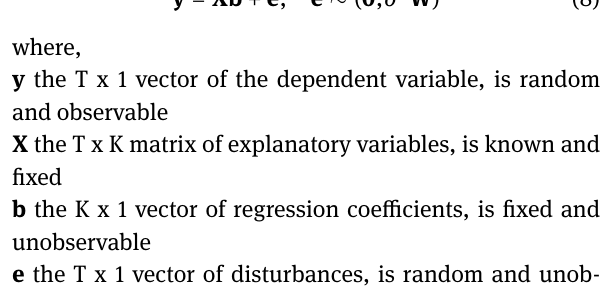
Fig. 7. MEI and the GLS residuals (mm) during the SA